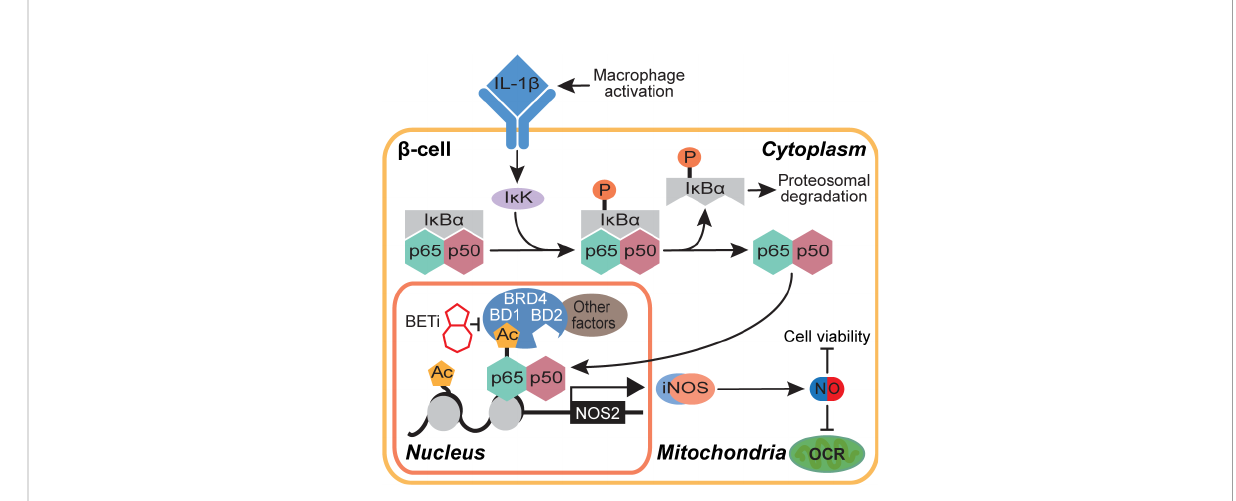
FIGURE 7 Schematic representation of the BET bromodomain inhibitor-driven decrease in NOS2 transcriptional activation